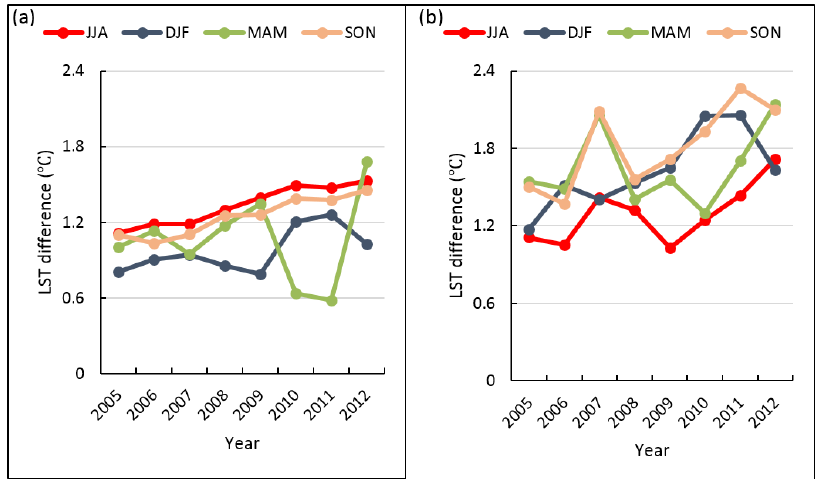
Table 1. The LST WFM-NNWF warming trend is found to be the largest in summer (0.51 °C/8 years), followed by autumn (0.48 °C/8 years), and winter (0.38 °C/8 years) at night. The LST GZ-NNWF holds similar warming trends but with larger magnitudes especially in autumn (0.80 °C/8 years) and winter (0.76 °C/8 years). These warming trends are statistically significant to the results of t -test [41] at 5% confidence level. The larger warming trends of LST GZ-NNWF compared to LST WFM-NNWF in our study area